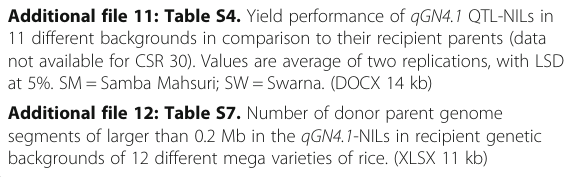
Additional file 11: Table S4. Yield performance of qGN4.1 QTL-NILs in 11 different backgrounds in comparison to their recipient parents (data not available for CSR 30). Values are average of two replications, with LSD at 5%. SM = Samba Mahsuri; SW = Swarna. (DOCX 14